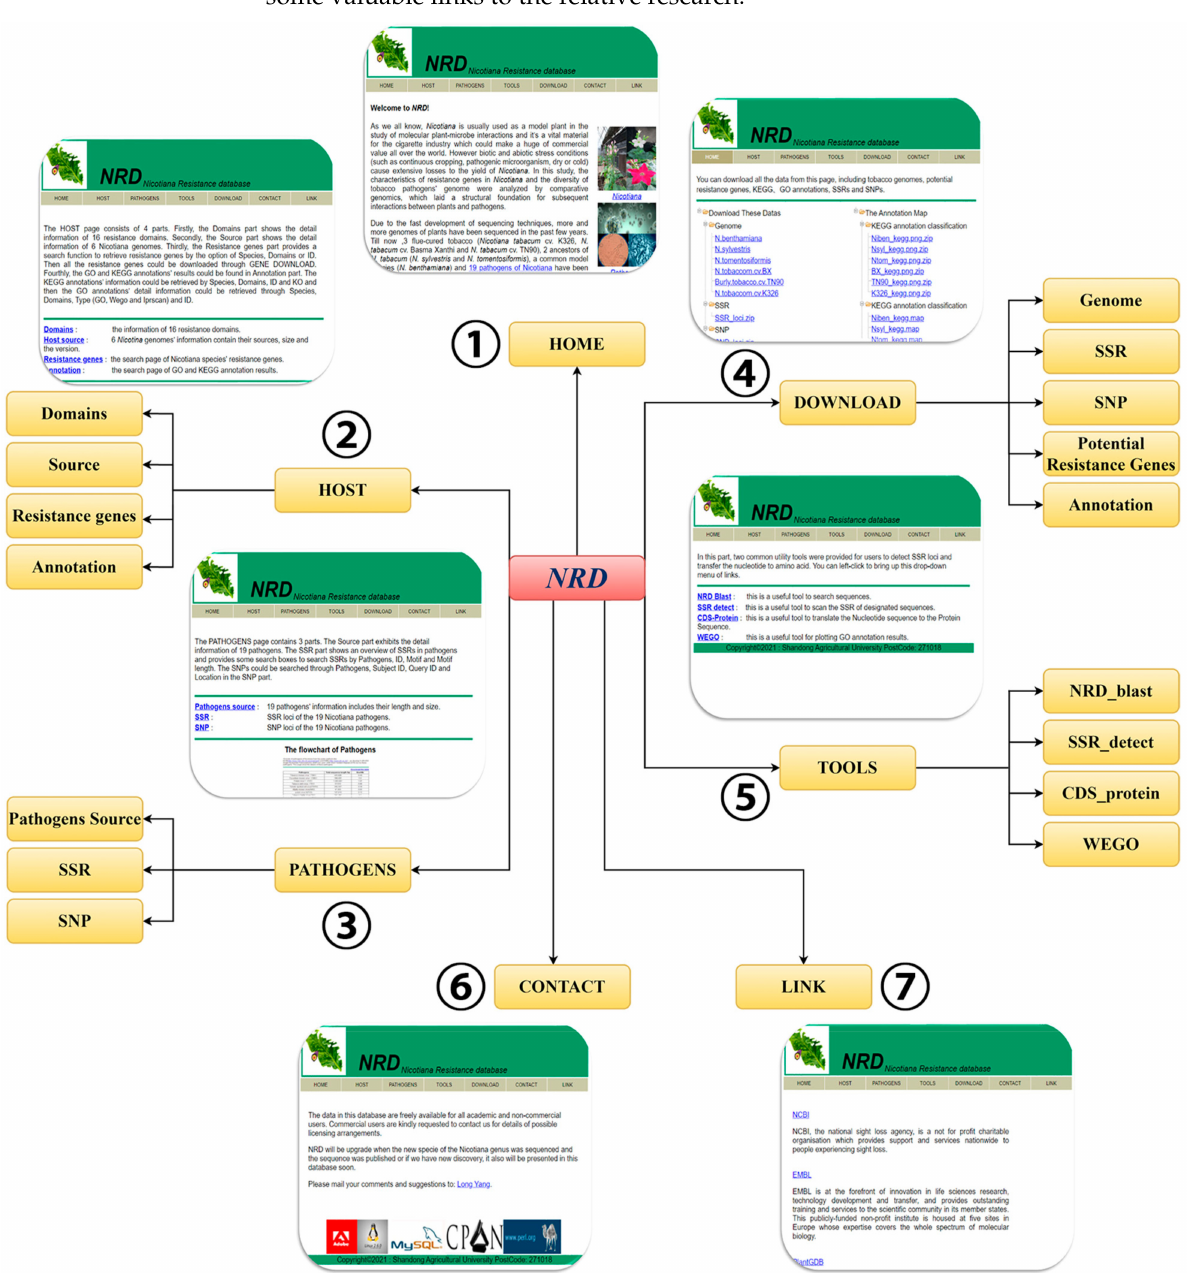
Figure 2. The framework of Nicotiana Resistance Database (NRD). 1 (cid:13) Home: introduction of the study and the frame-chart of NRD. 2 (cid:13) Host: provides the information of six Nicotiana genomes and 16 resistance families. Users can search the resistance genes in the drop-down menu. 3 (cid:13) Pathogens: provides the information of 19 pathogens and provides the users with search boxes for the Simple Sequence Repeats (SSRs) and Single Nucleotide Polymorphisms (SNPs) loci. 4 (cid:13) Download: the data can be downloaded on the page. 5 (cid:13) Tools: utility tools are offered to users to detect SSRs loci and transfer the nucleotide to an amino acid. 6 (cid:13) Contact: mailbox of the authors. 7 (cid:13) Link: some useful